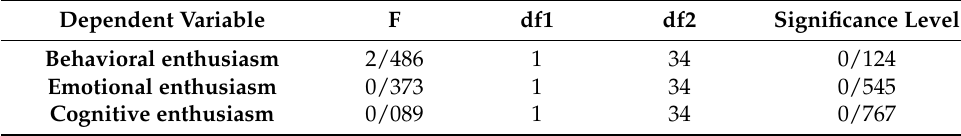
Table 4. Leven test for assessing the same assumption of